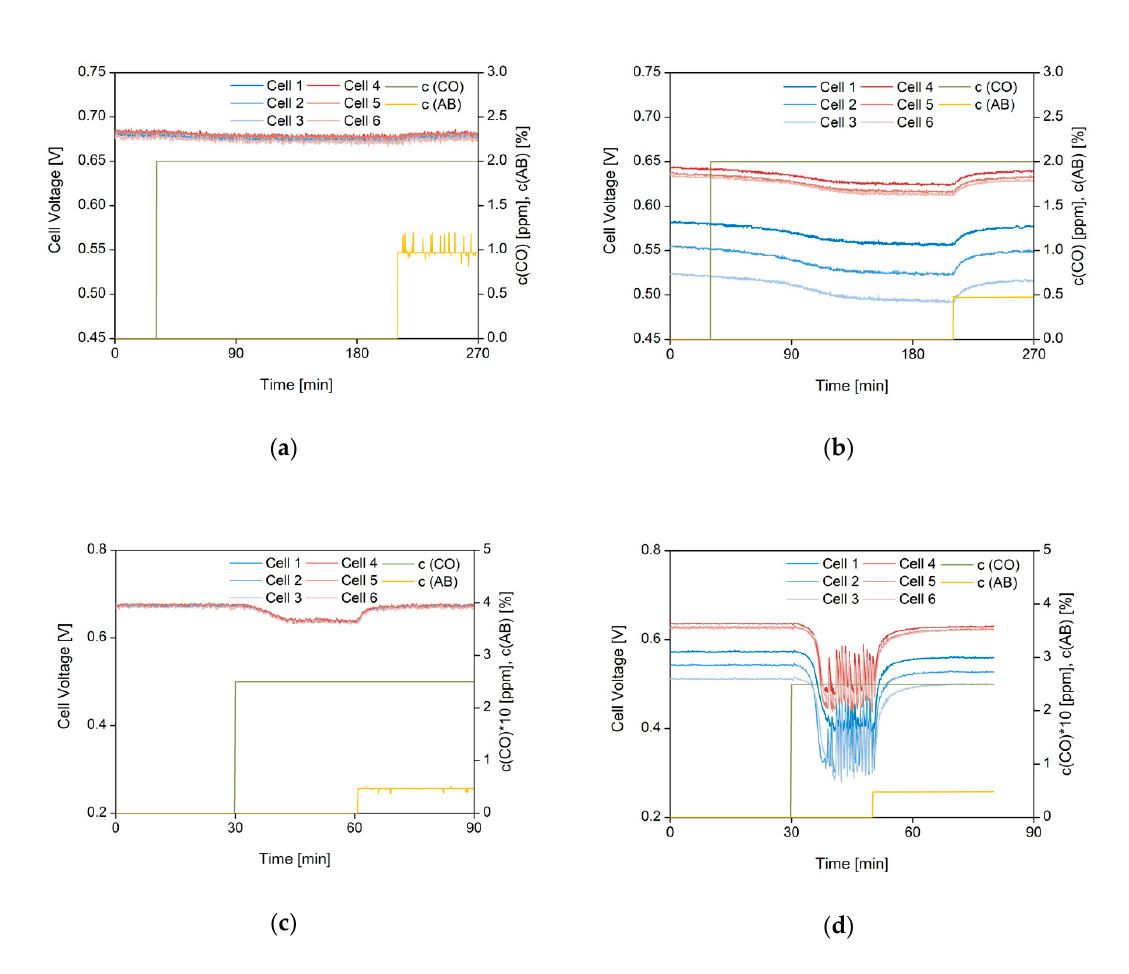
Figure 2. Voltage versus time curve of ( a ) Stack 01 with 2 ppm CO, ( b ) Stack 02 with 2 ppm CO, ( c ) Stack 01 with 25 ppm CO, and ( d ) Stack 02 with 25 ppm CO. All of the measurements have carried out at 80 A.